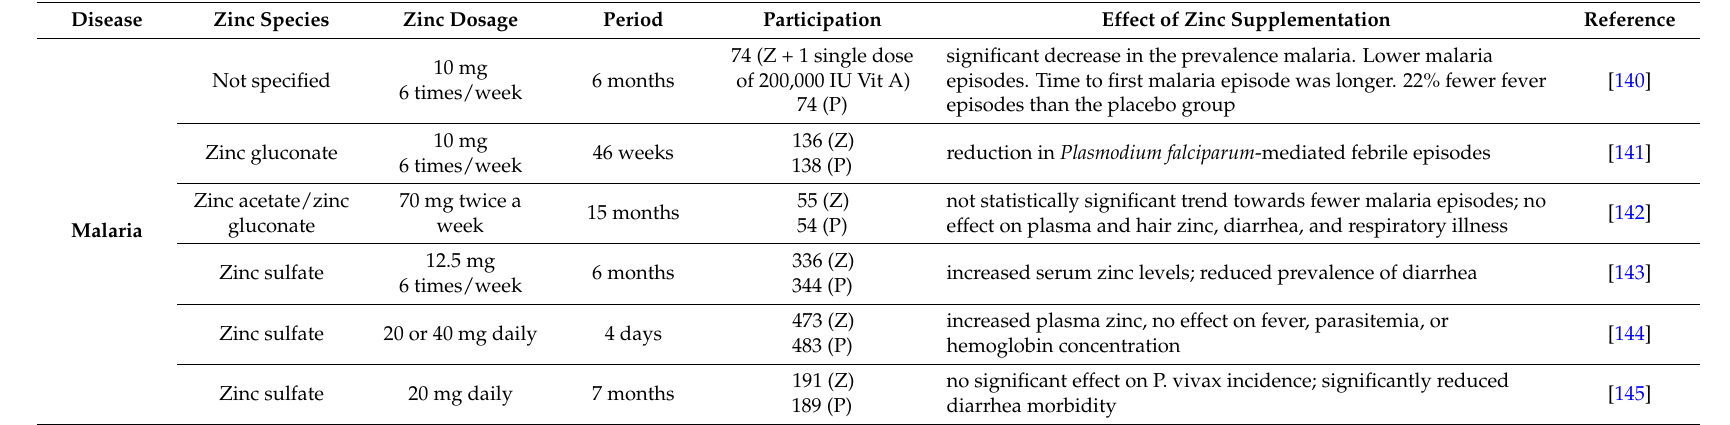
Table 3. Zinc supplementation and parasites (updated from